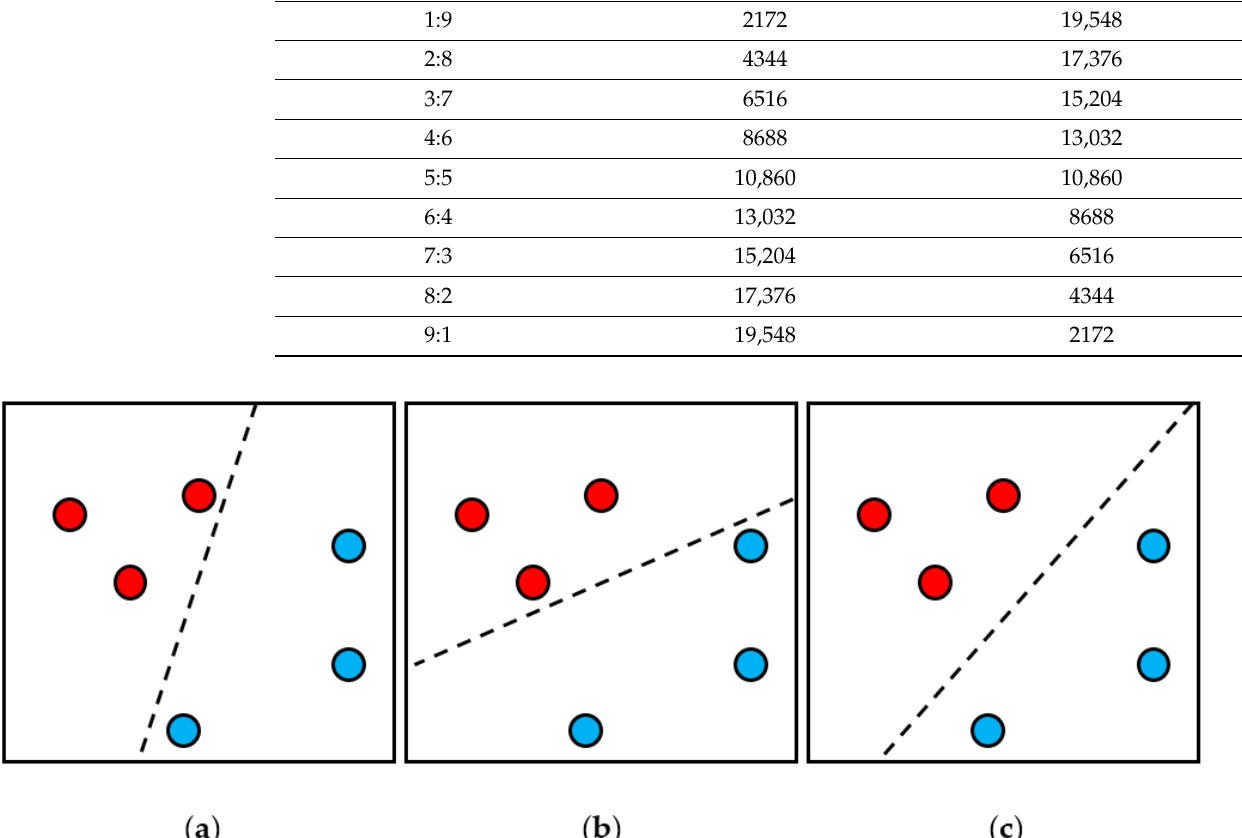
Figure 9. A conceptual diagram of the SVM segmentation data; ( a , b ) show the poor segmentation results, ( c ) shows the best segmentation results.